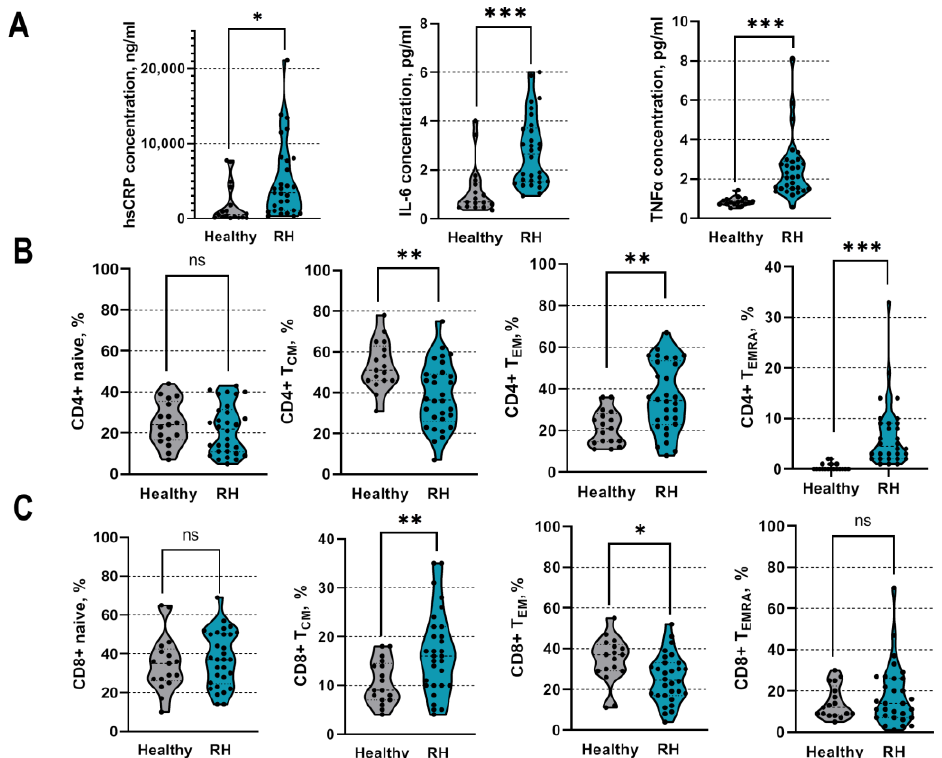
Figure 1. Comparison of inflammatory activity between patients with resistant hypertension and healthy controls. ( A ) — Concentrations of various pro-inflammatory cytokines and proteins among study groups at entry. ( B , C ) — The frequencies of different T-cell subsets among healthy individuals and patients with resistant hypertension at study entry. RH — resistant hypertension, hsCRP — high- sensitivity C-reactive protein, TNF- α— tumor necrosis factor alfa, IL-6 — interleukin 6, CD4+ — T helper cells, CD8+ — T cytotoxic cells, T CM — central memory cells, T EM — effector memory cells, T EMRA — effector memory residential cells. *** represents significant difference between the groups with p < 0.001, ** p < 0.01, * p < 0.05, ns – not significant using unpaired t -test or Mann – Whitney test.